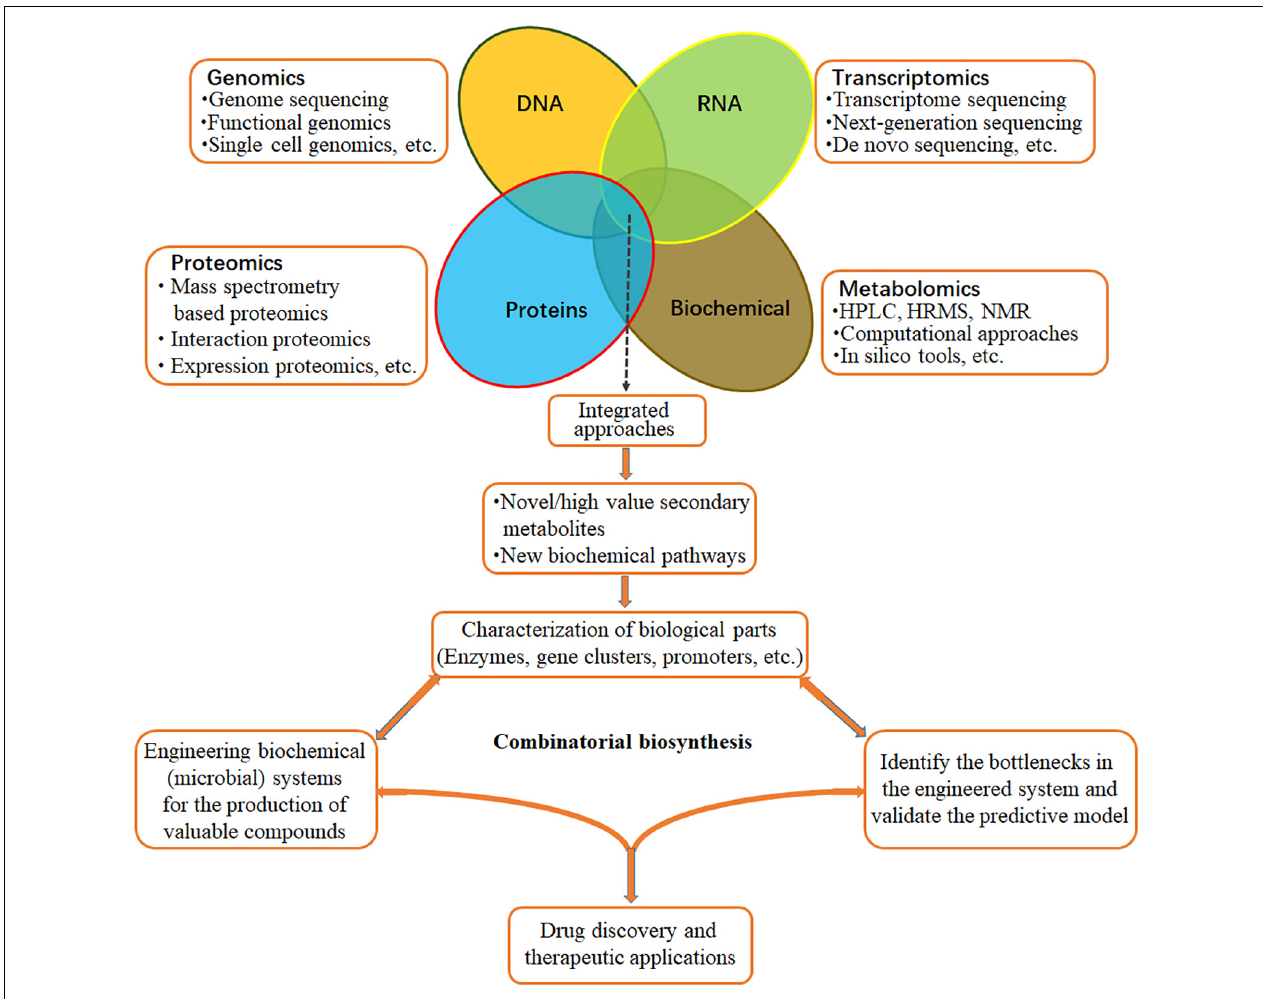
FIGURE 4 | Integrated approaches for production of bioactive medicinal ingredients. Combining multiple “omics” datasets will facilitate the discovery of novel bioactive specialized metabolites and characterization of the related biosynthesis pathways in Dendrobium species. Based on the obtained knowledge, novel combinatorial biosynthesis systems can be engineered for the production of new and interesting specialized metabolites.